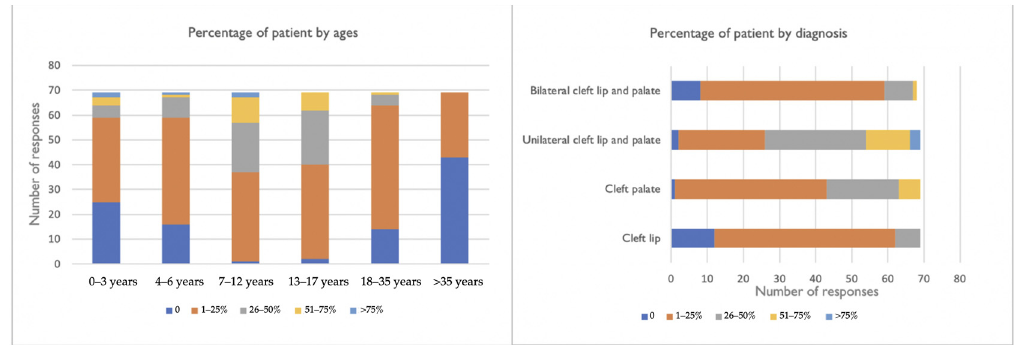
Figure 2. Distribution of patient by ages and diagnosis. Table 2. Survey results on distribution of patients with CLP by office environment.